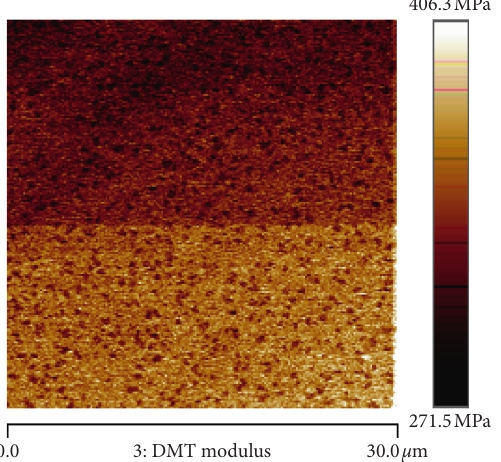
Figure 10: DMT modulus diagram of #70 matrix asphalt+ 30% preactivated Buton rock powder.